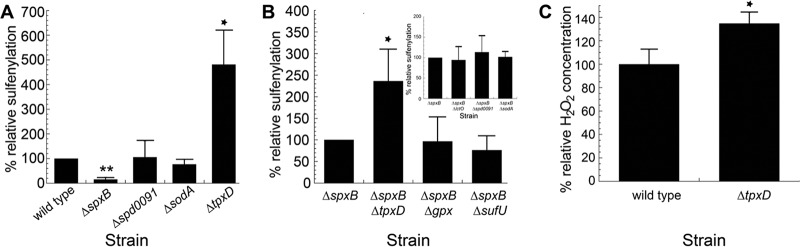
TpxD controls proteome sulfenylation levels in S. pneumoniae. (A) Relative S. pneumoniae GapA sulfenylation profiles of various deletion strains of S. pneumoniae relative to the wild-type (IU1690) strain. The deletion strains have the genotypes ΔspxB (IU2181), Δspd0091 (IU3602), ΔsodA (IU3606), and ΔtpxD (IU3610) (Table S1A). (B) Relative S. pneumoniae GapA sulfenylation levels in various double deletion strains of S. pneumoniae relative to the ΔspxB (IU2173) strain. The strains tested have the genotypes ΔspxB ΔtpxD (IU3611), ΔspxB Δgpx (IU3614), ΔspxB ΔsufU (IU3617), ΔspxB ΔlctO (IU3284), ΔspxB Δspd0091 (IU3603), and ΔspxB ΔsodA (IU3607). (C) Relative H2O2 concentration in wild type (IU1690) versus ΔtpxD (IU3610) S. pneumoniae strains measured under our microaerophilic conditions. *, P ≤ 0.05, and **, P ≤ 0.005, based on a one-sample t test.